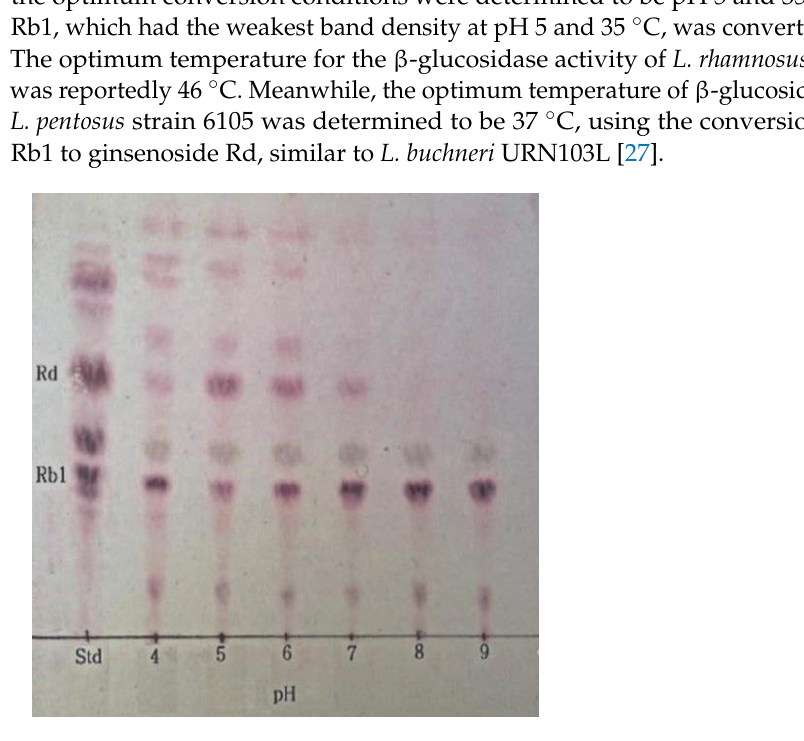
Figure 4. TLC analysis of ginsenoside Rb1 hydrolyzed by crude enzyme of isolated strain URN103L at different pHs (4.0, 5.0, 6.0, 7.0, 8.0, and 9.0) at 35 °C for 7 days.